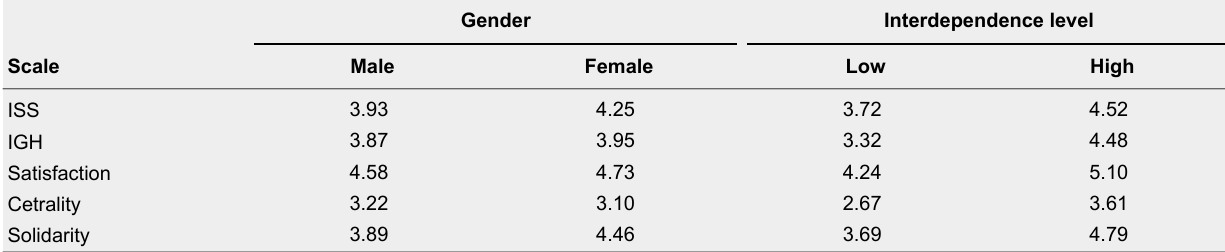
Study 2: Identification Scores by Gender and Interdependence Level